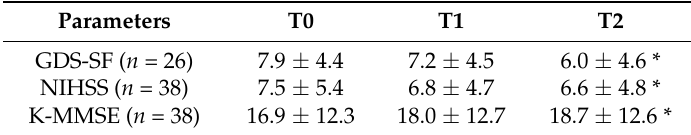
Table 2. Change of clinical variables.